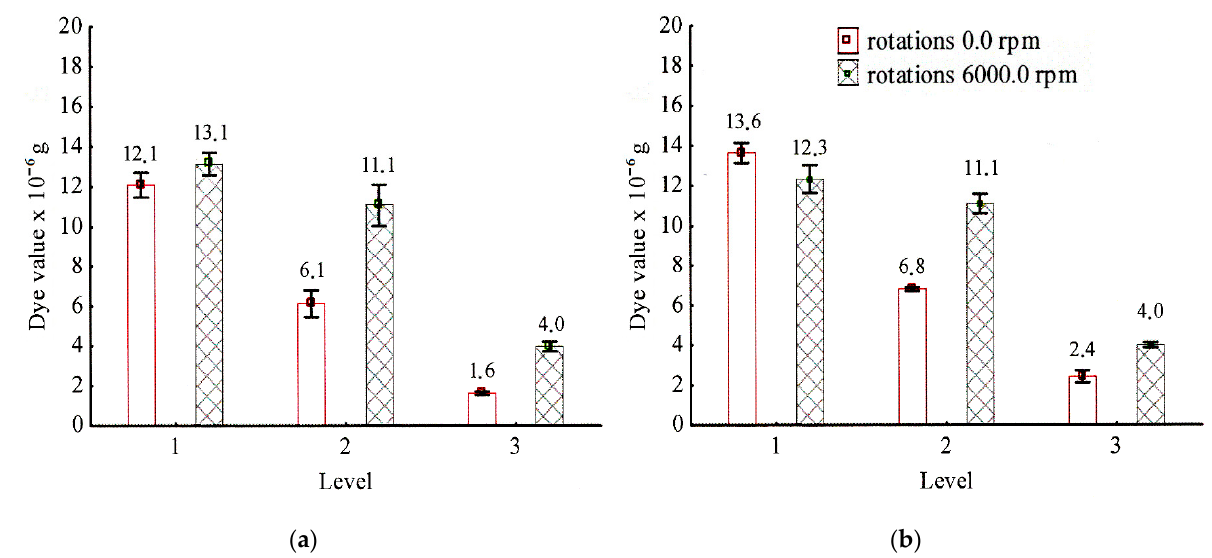
Figure 5. Distribution of the dye at individual levels of the tree crown depending on the distance between the trees and the rotational speed of the drone rotors at air-injector flat spray nozzle: ( a ) tree distance 0.5 m; ( b ) tree distance 1.0 m.